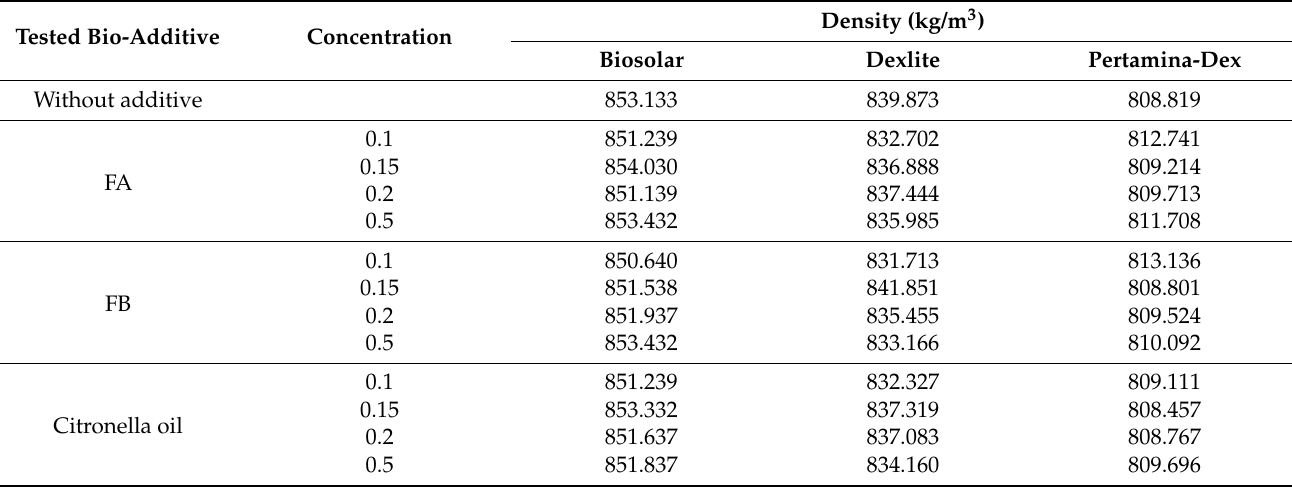
Table 8. Density of fuel-bio additive blending.